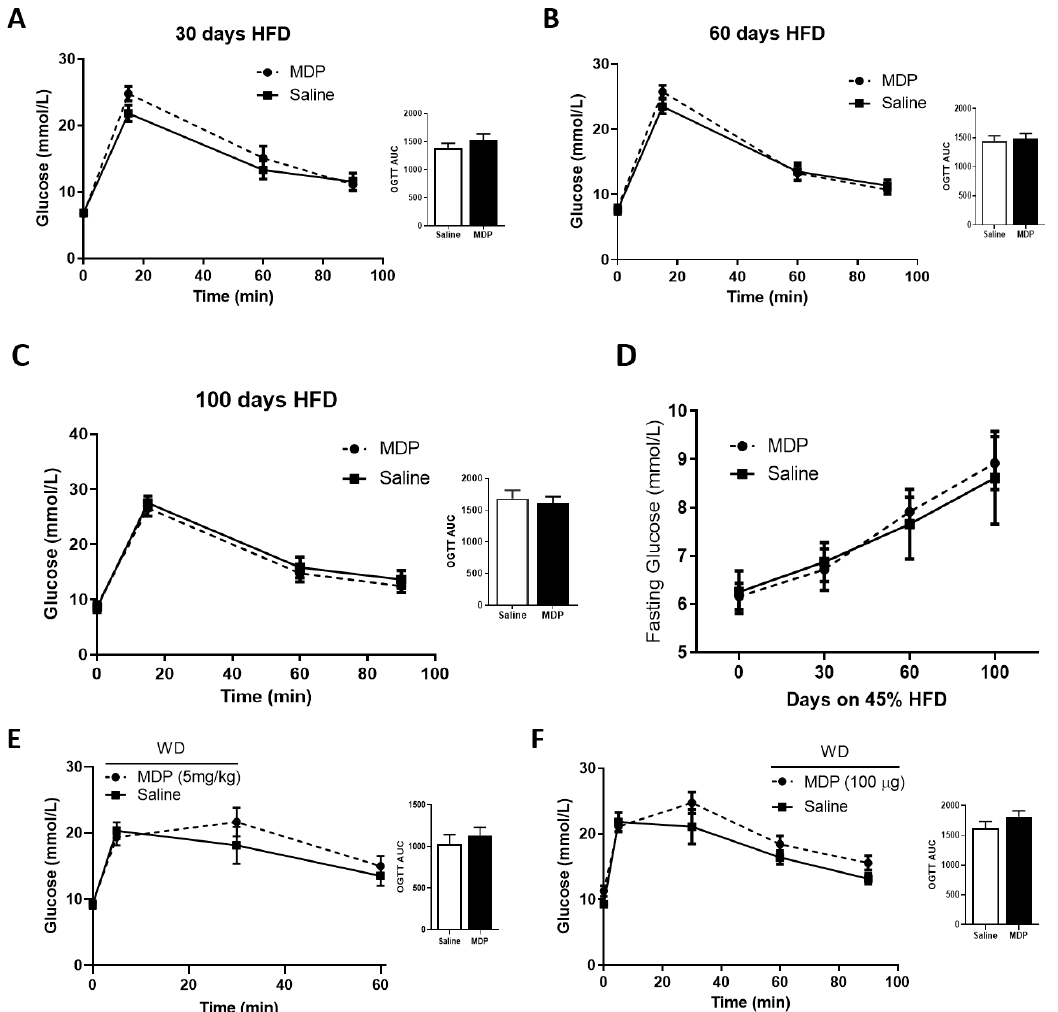
Figure 5. MDP has no effect on glucose clearance in mice fed obesogenic diets. Oral glucose tolerance test (2 g / kg) ( A – C ) and fasting blood glucose ( D ) were measured after 30 days ( A ), 60 days ( B ) and 100 days ( C ) on a 45% high-fat diet (HFD) after mice received two IP injections of MDP (5 mg / kg)